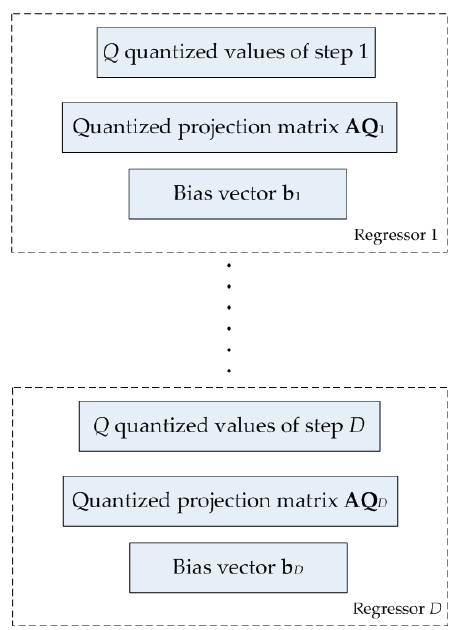
Figure 6. The diagram of the compressed data storage arrangement.